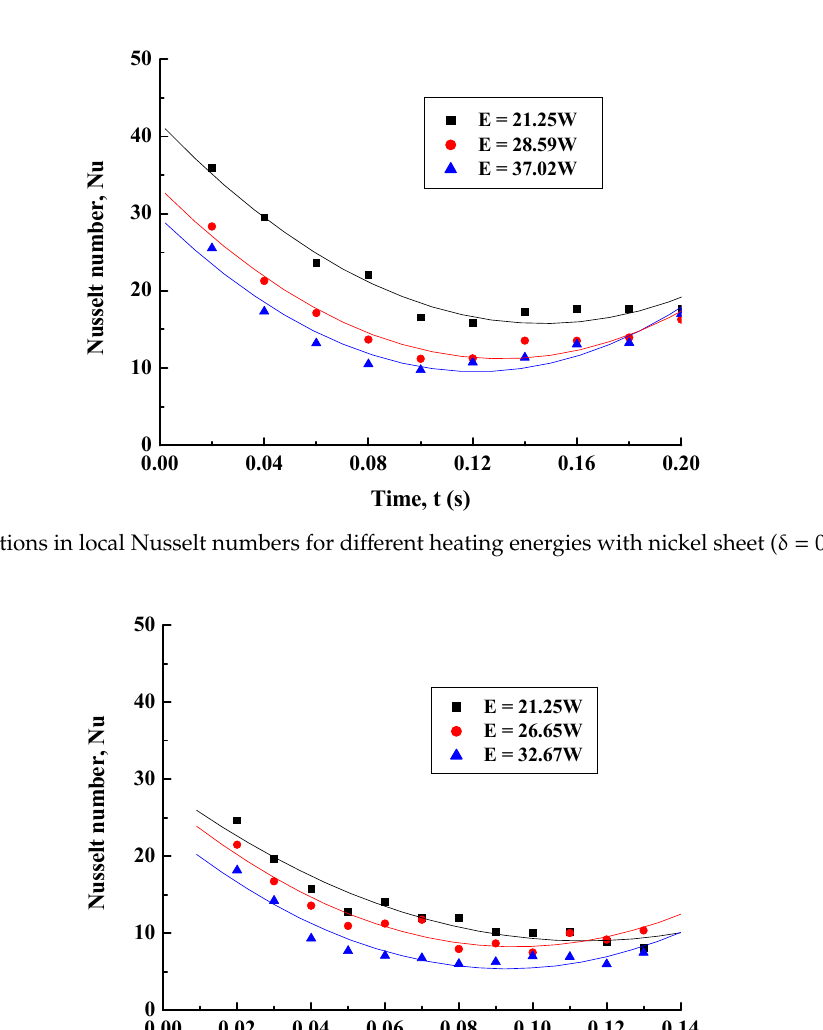
Figure 6. The methodology for the calculation of local position of fringe. ( a ) Reference, ( b ) Real state.